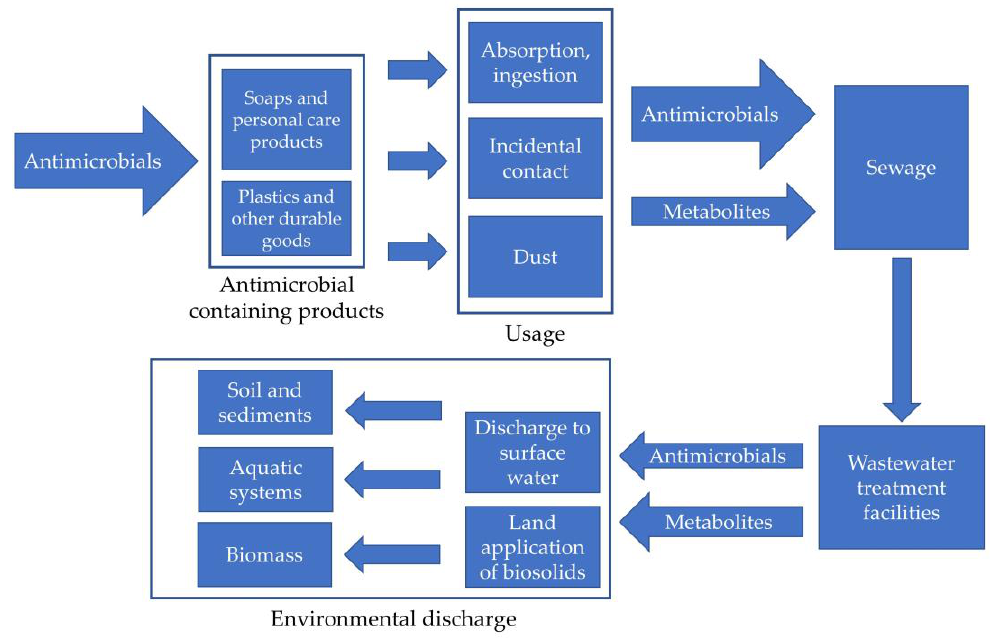
Figure 2. Flow of antimicrobials and their metabolites from products to the environment.